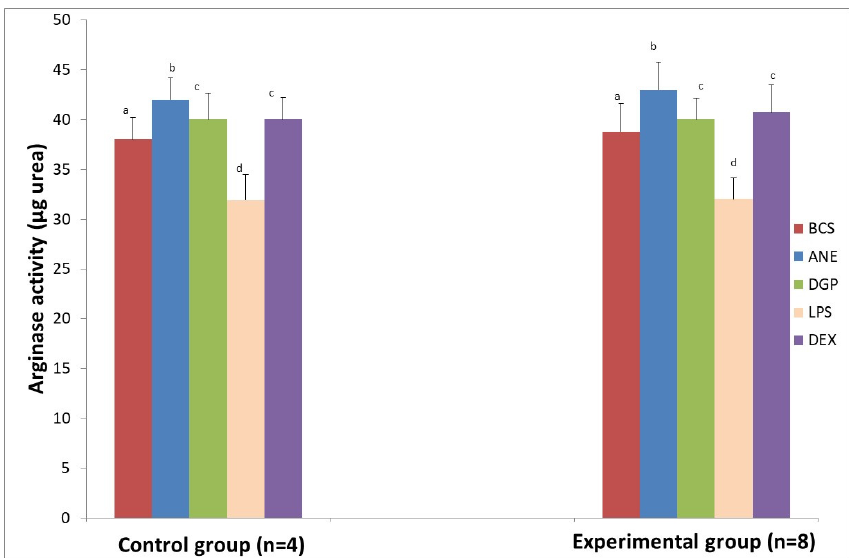
Figure 8. Arginase activity in lysates of MDMs isolated from sheep during implantation of Ti implant into the tibia in the control group ( n = 4) and the experimental group ( n = 8). BCS—macrophages stimulated only with bovine calf serum, ANE—antimicrobial neutrophil extract, DGP—neutrophil degranulation product, LPS—lipopolysaccharide, DEX—dexamethasone. Values are mean ± SE obtained from each separate experiment conducted in both groups of sheep. There are significant differences between mean values marked with different letters ( p < 0.05) compared to BCS group.